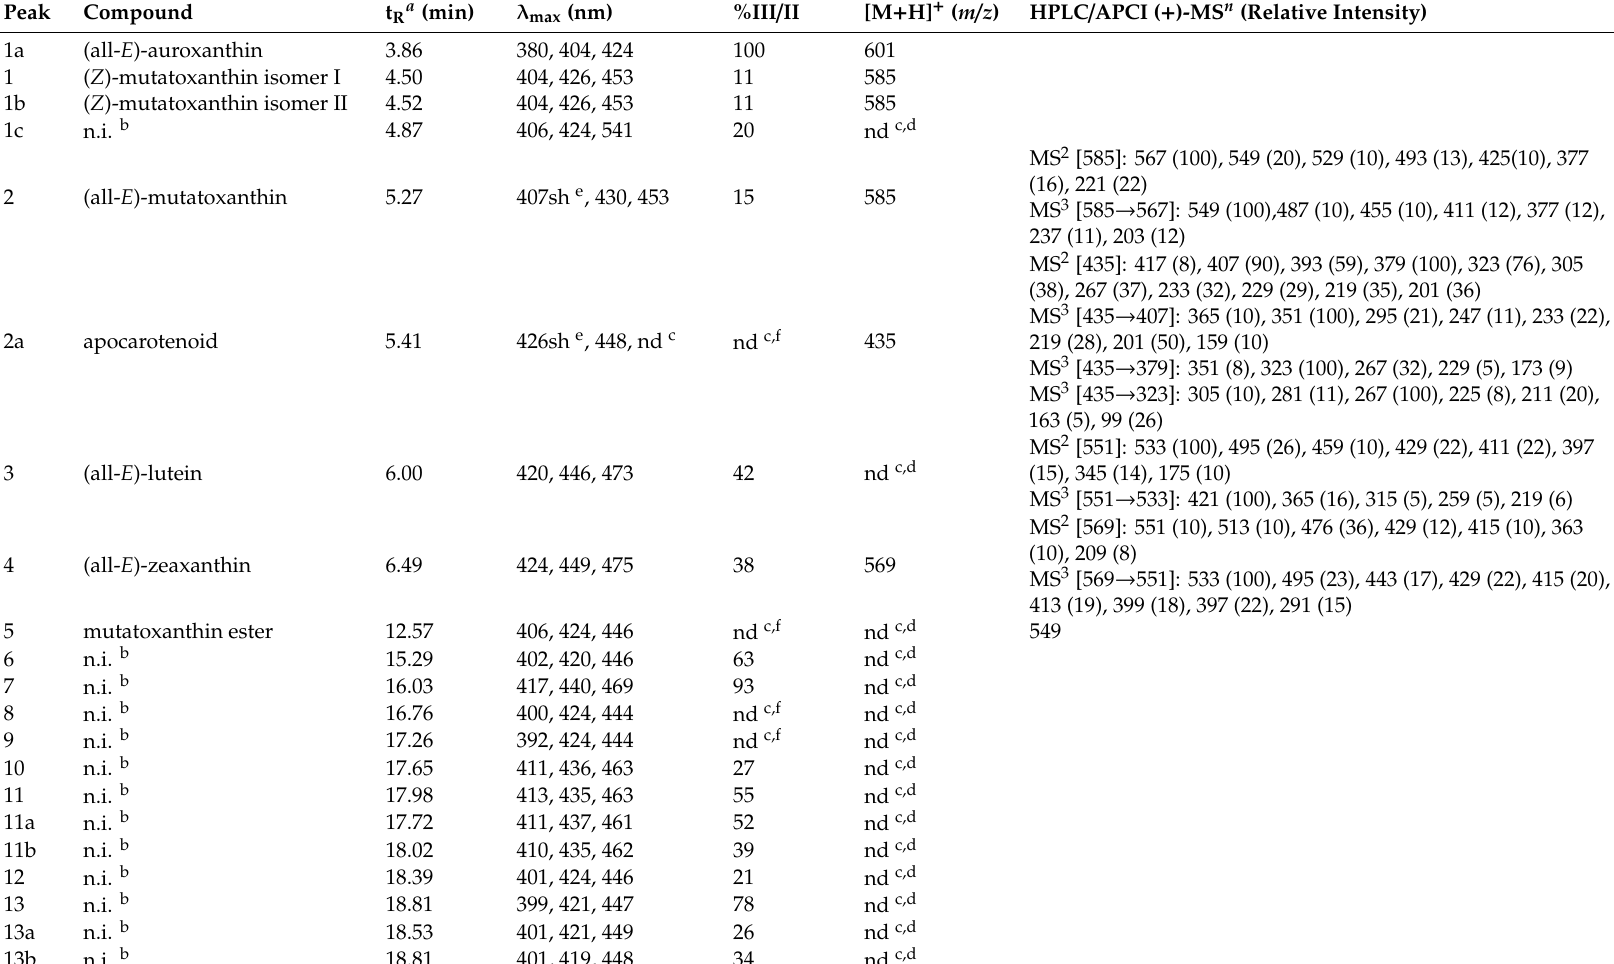
Table 3. Chromatographic, UV / Vis, and mass spectrometric characteristics of carotenoids from orange juice, obtained by HPLC-DAD-APCI- MS n .